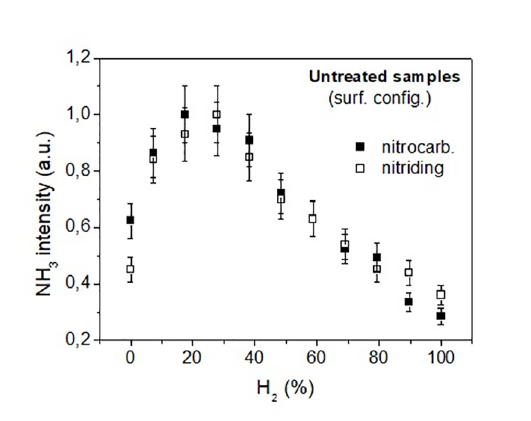
Figure 8. Evolution of the ammonia ion peak (NH 3+ ) obtained for the surface configuration using an untreated sample, during nitriding and nitrocarburizing